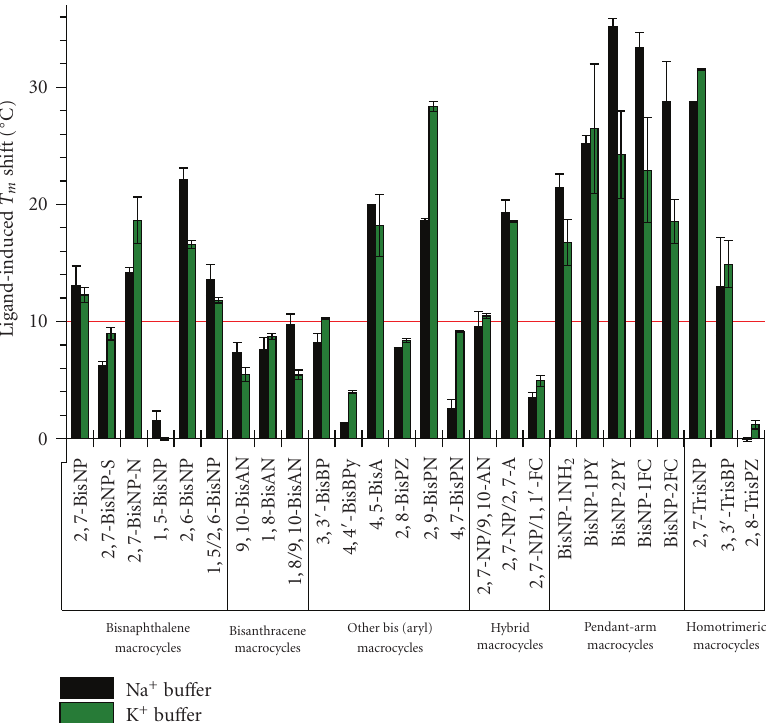
Figure 4: Stabilisation of F21T oligonucleotide ( Δ T 1 / 2 , ◦ C) induced by CBI macrocycles (1 μ M) in Na + - (black bars) or K + -rich conditions (green bars); see main text for experimental